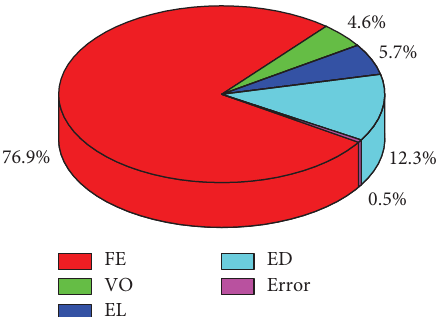
Figure 5: Contribution percentage of each parameter for MRR.